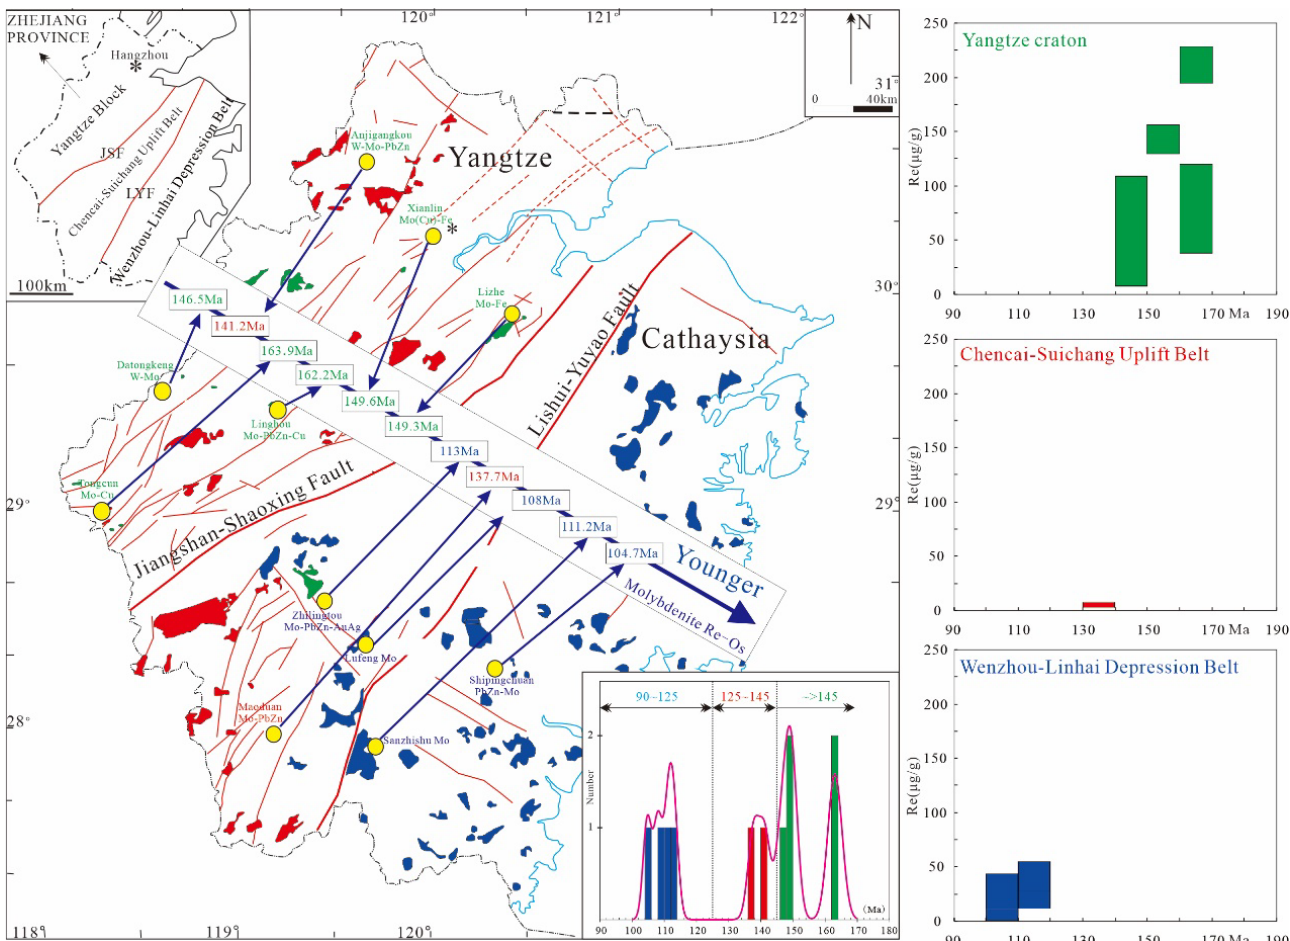
Figure 7. The distribution map and cumulative probability diagram of isotopic ages for the Mo polymetallic deposits in Zhejiang Province, showing the variation of Re content in molybdenite from the three-stage Mo polymetallic deposits.